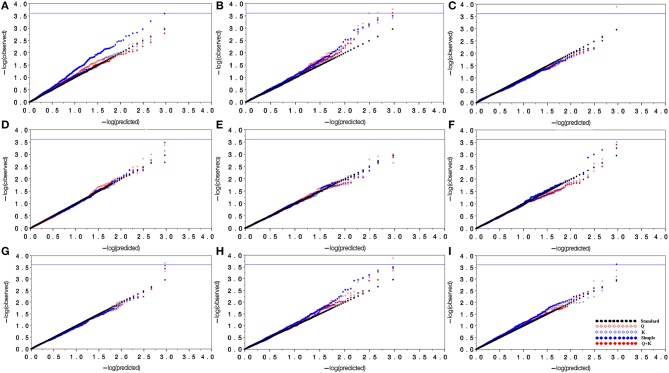
Quantile-quantile plots for model comparison with biomass yield and related traits. (A), Evaluation of model types using markers for tiller number; (B), Evaluation of model types using markers for plant height; (C), Evaluation of model types using markers for tiller diameter; (D), Evaluation of model types using markers for internode number; (E), Evaluation of model types using markers for internode length; (F), Evaluation of model types using markers for leaf length; (G), Evaluation of model types using markers for leaf width; (H), Evaluation of model types using markers for fresh biomass yield; (I), Evaluation of model types using markers for dry biomass yield. In this figure, black dots line represent the predicted value equal to the observed value; blue dots represent the simple linear model (without population structure and relative kinship); red diamond represents the Q model; blue diamond represents the K model; and red dots represent the Q+K model.